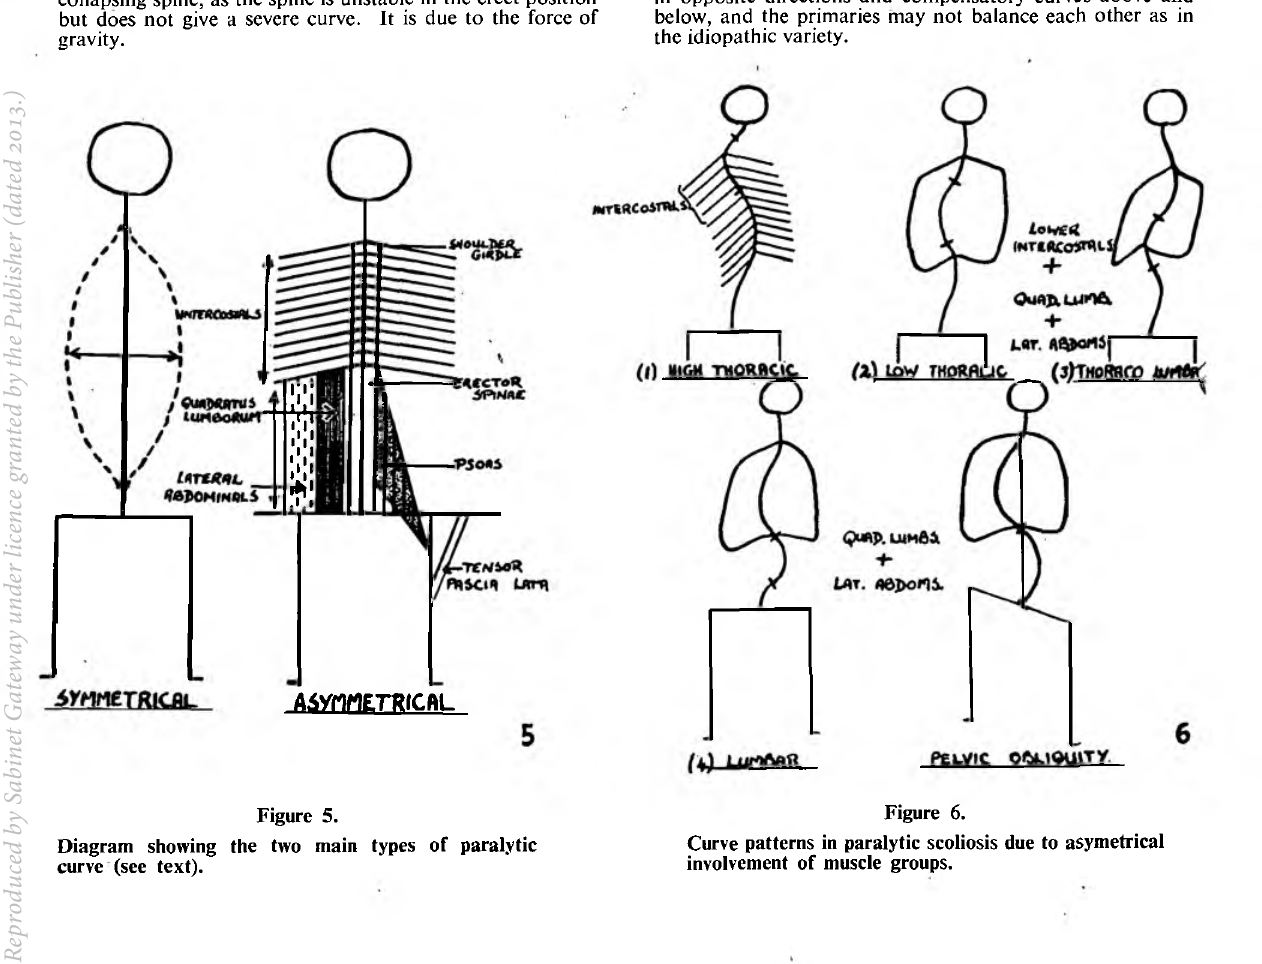
Figure 6. Curve patterns in paralytic scoliosis due to asymetrical involvement of muscle